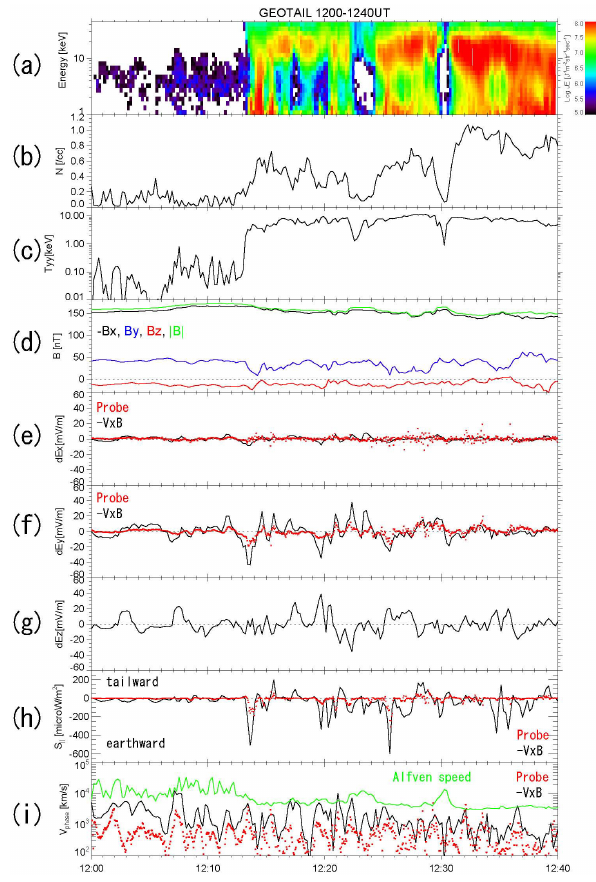
Fig. 3. (a) Energy-time diagram of ion, (b) ion density, (c) ion temperature, (d) magnetic field in GSM, (e–g) three components of electric field perturbation, (h) field-aligned Poynting flux, (i) phase velocity and Alfv´en